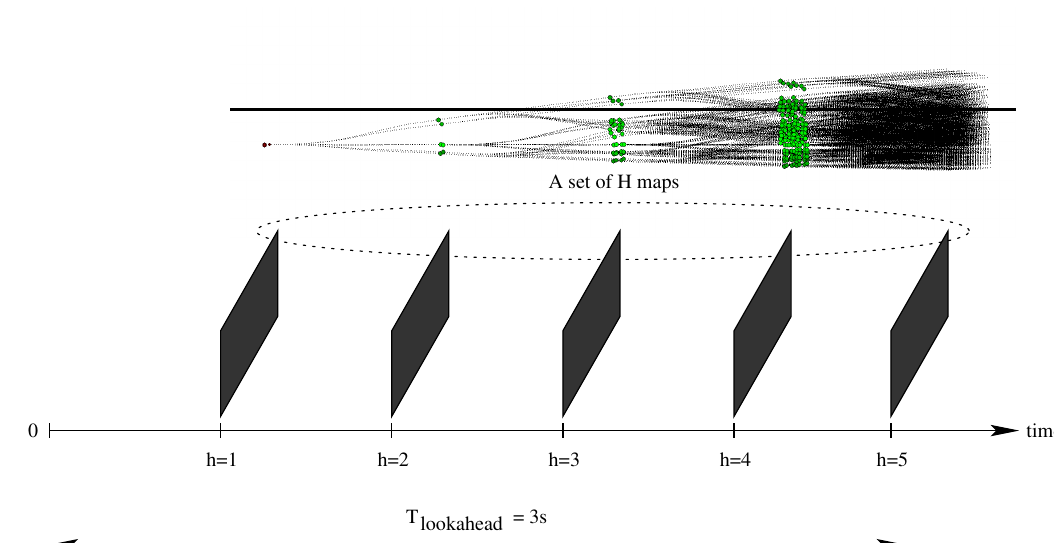
Figure 11. The synchronous communication scheme: The path planner runs once every time the data-fusion system generates a set of maps. The path-planner generates an expansion tree of depth 5, i.e., h ∈ [ 1, H ] = [ 1,5 ] , and spanning a total lookahead time of 3 s in the future. Consequently, the data-fusion system must generate, and transfer to the planner, a set of H = 5 maps. These maps must represent the environment in the future every T sim = 600 ms, i.e., at T 0 , T = T 0 + 600 ms, T = T 0 + 1200 ms,